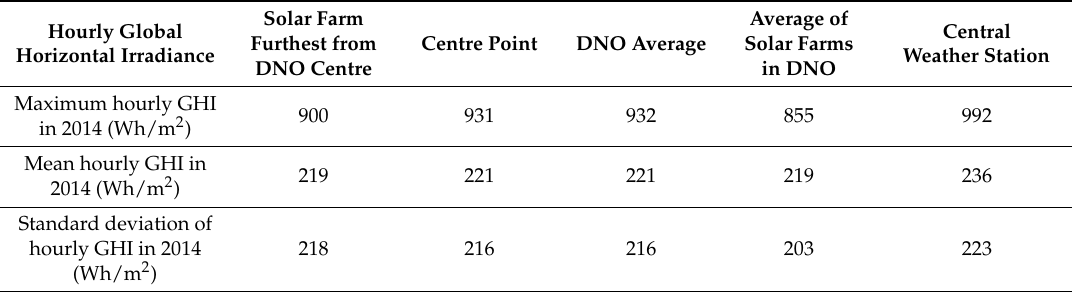
Table 2. Results of applying alternative solutions to MAUP in Southwest